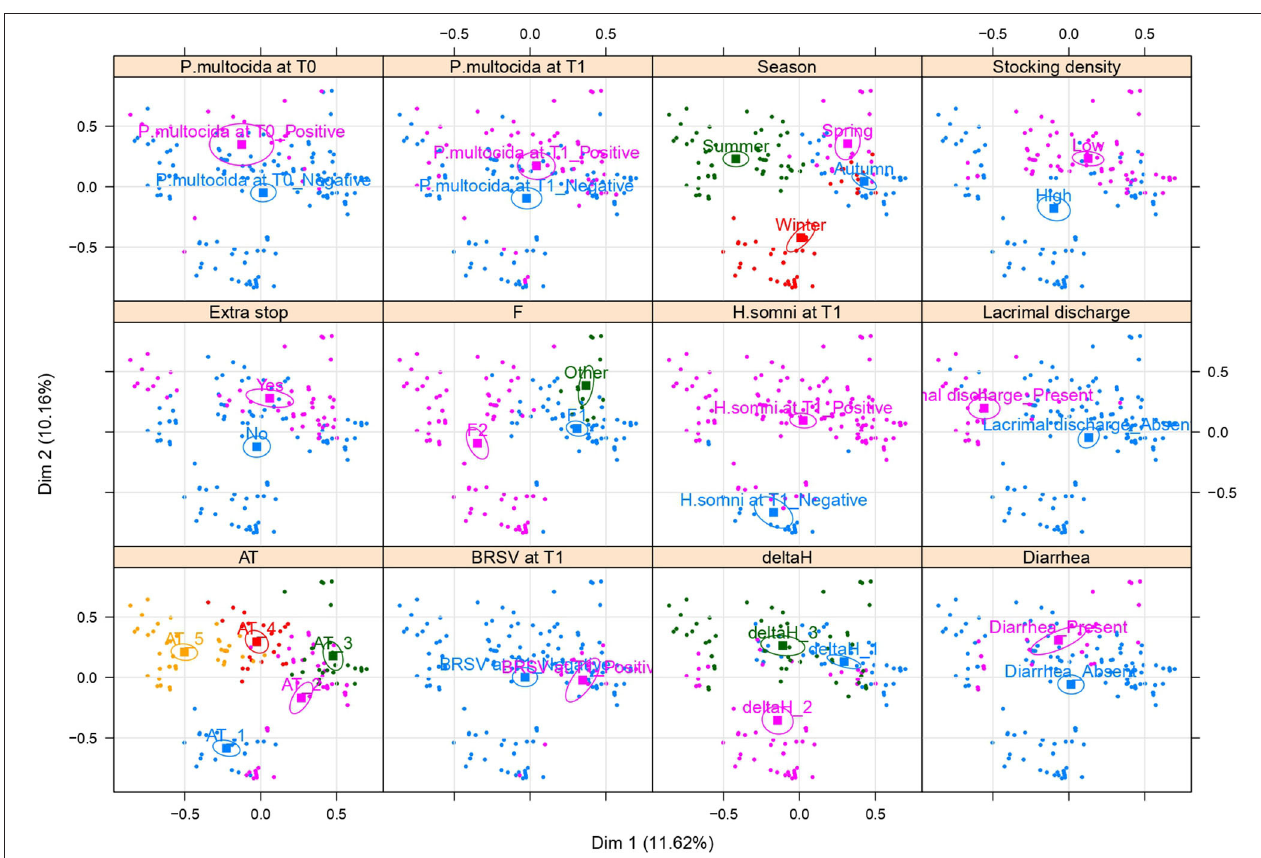
FIGURE 2 | The multiple correspondence analysis (MCA) biplot with Dimension 1 (Dim1) as x-axis and Dimension 2 (Dim2) as y-axis, with the explained variance between brackets. Different colors and confidence ellipses are drawn for the main variables entering the first two dimensions and explaining most of the variance noticed in the sample of 169 beef steers transported over a long-distance journey from France to Italy. F, farm of arrival; AT, arrival temperature; 1 H, delta humidity between arrival and